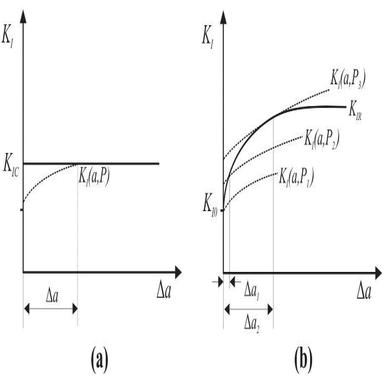
Crack propagation in (a) unstable manner (b) stable manner due to R-curve.